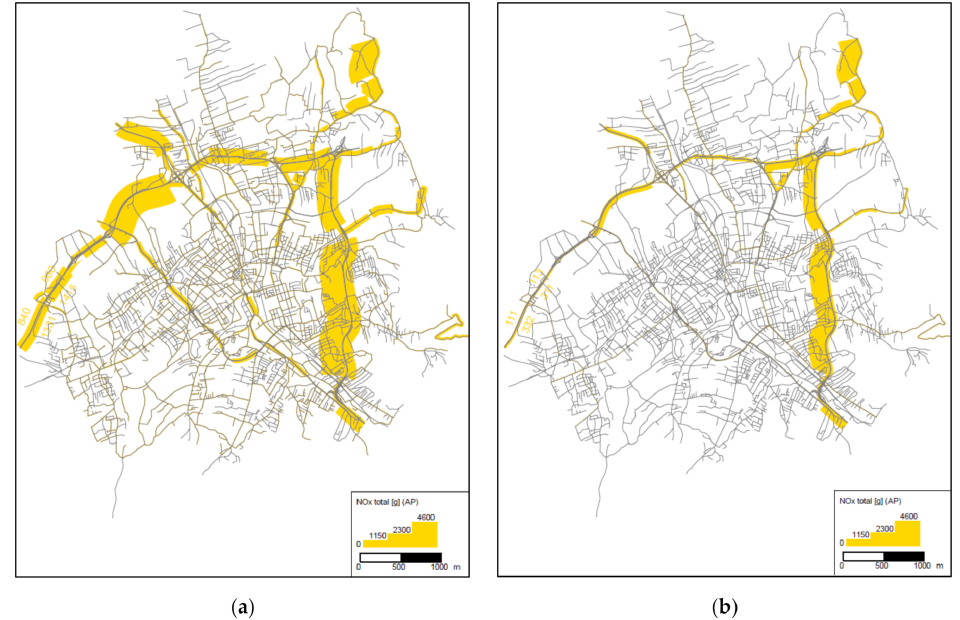
Figure 8. The assessment of nitrogen oxides (NOx) total [g] (measure from Group 1) for scenario W0 and optimal scenario (W4)—analysis for the whole city: ( a ) measure for scenario W0; ( b ) measure for scenario W4.